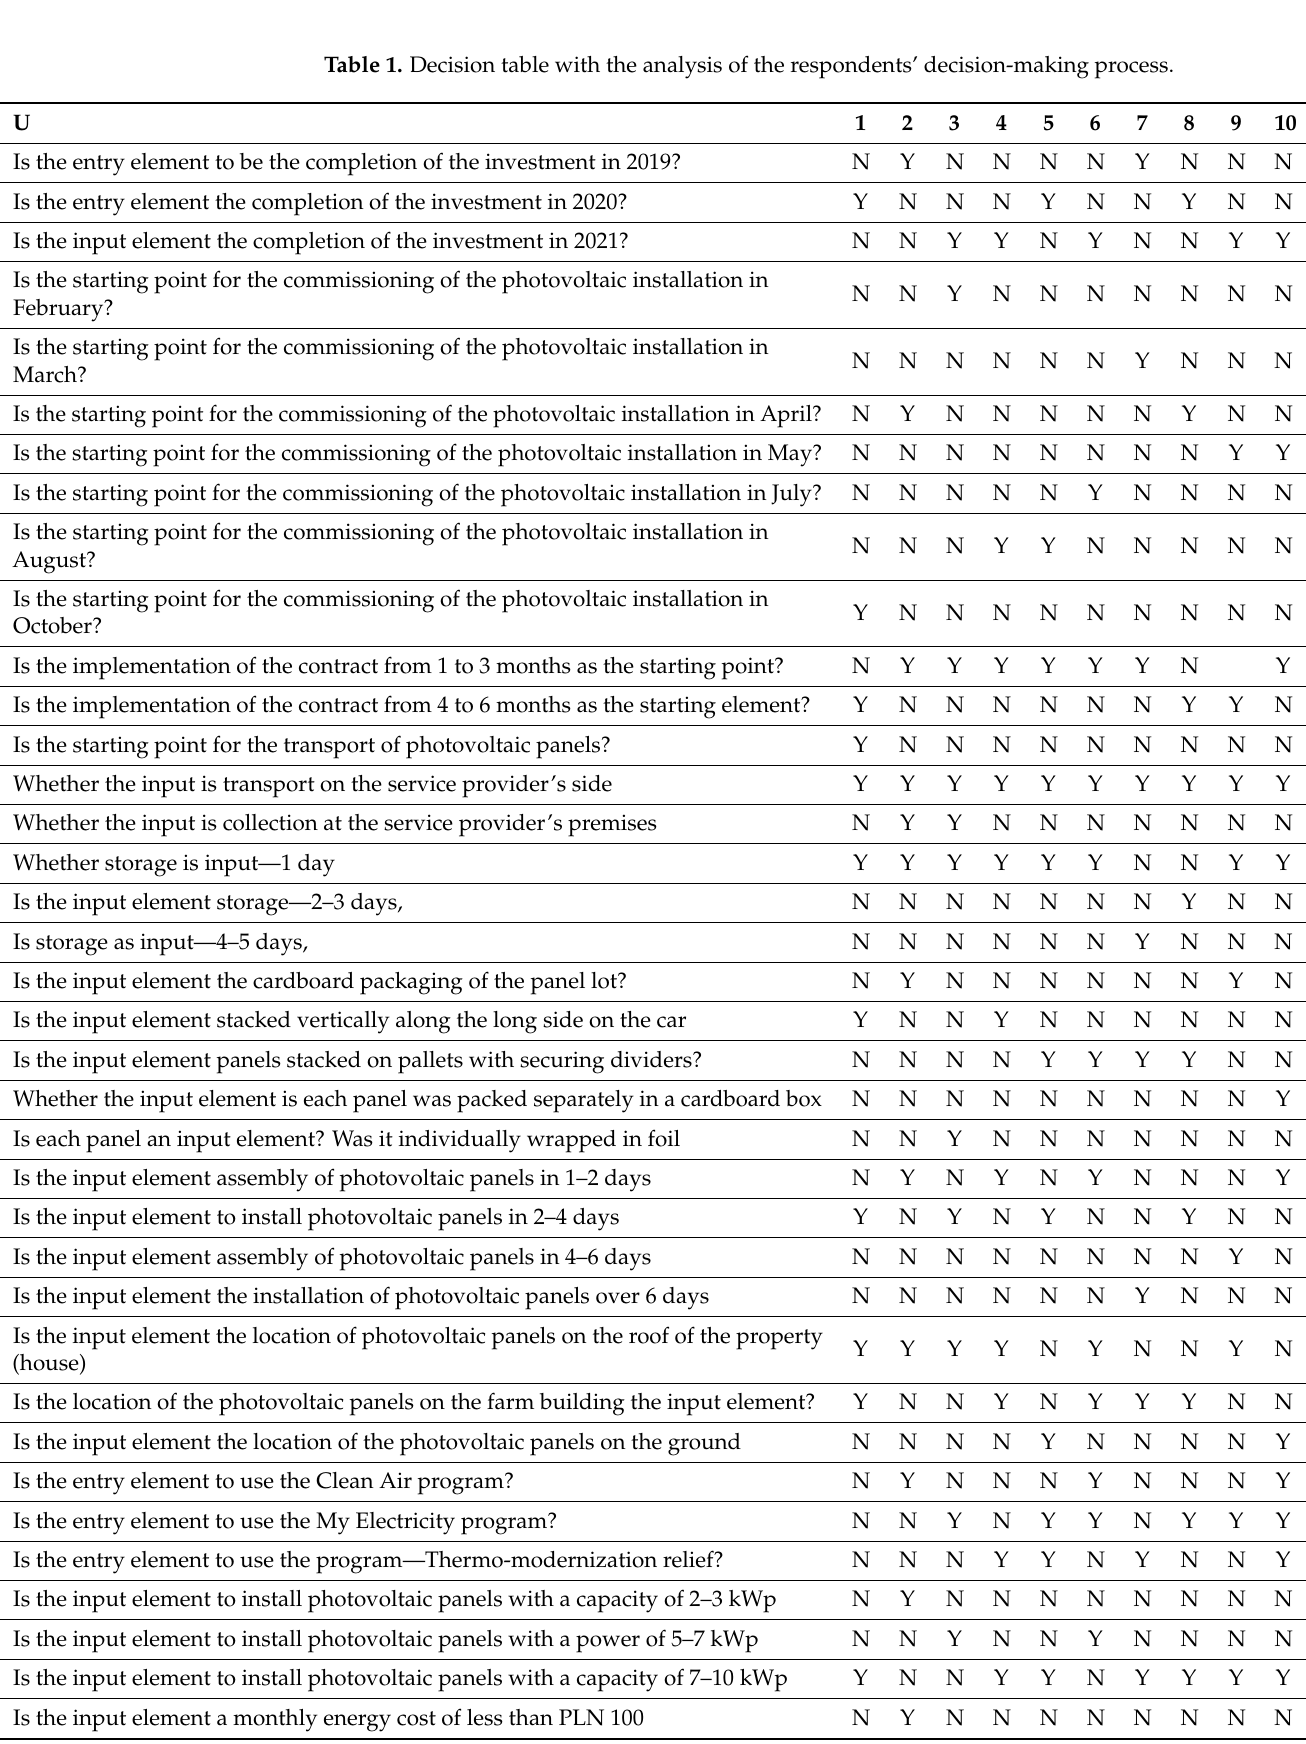
Table 1. Decision table with the analysis of the respondents’ decision-making